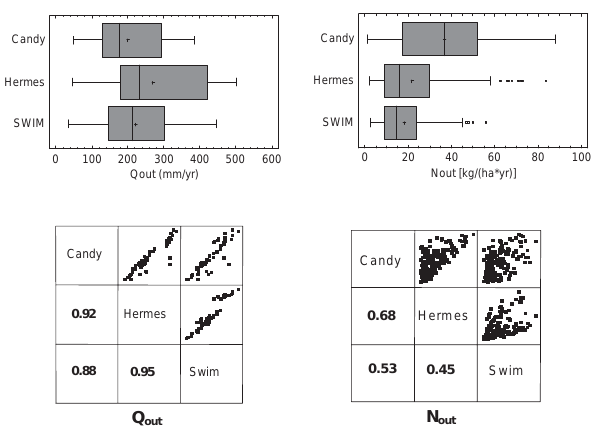
Fig. 4. Box-Whisker-Plots and Correlation-Scatterplot-Matrices for simulated percolation (Q out ) and simulated N-leaching (N out ); 162 simulation variants; boxes: interquartil range (IQR), whiskers: 1.5 · IQR, median: vertical line, mean: +.